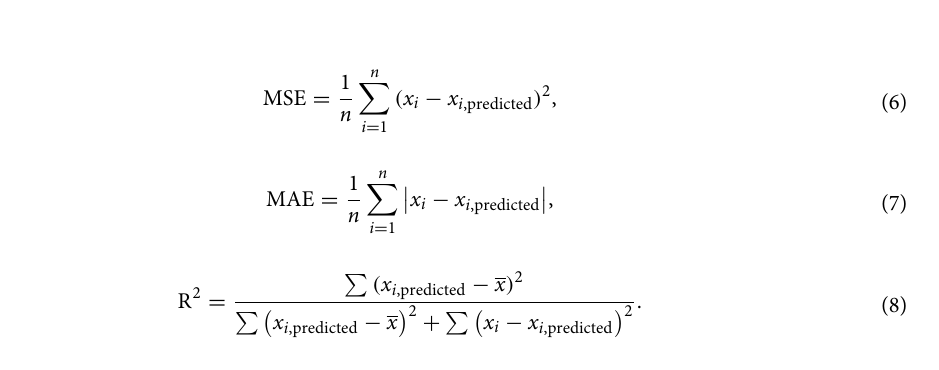
Figure 4. Distribution of the formation energy and lattice parameter given by DFT: ( a ) a (FCC), ( b ) a (BCC), ( c ) (cid:31) E f (FCC), and ( d ) (cid:31) E f